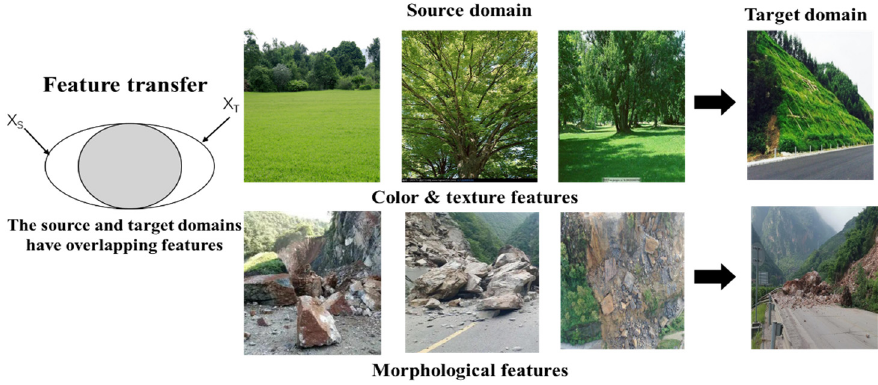
Figure 6. Schematic diagram of the feature transfer learning.